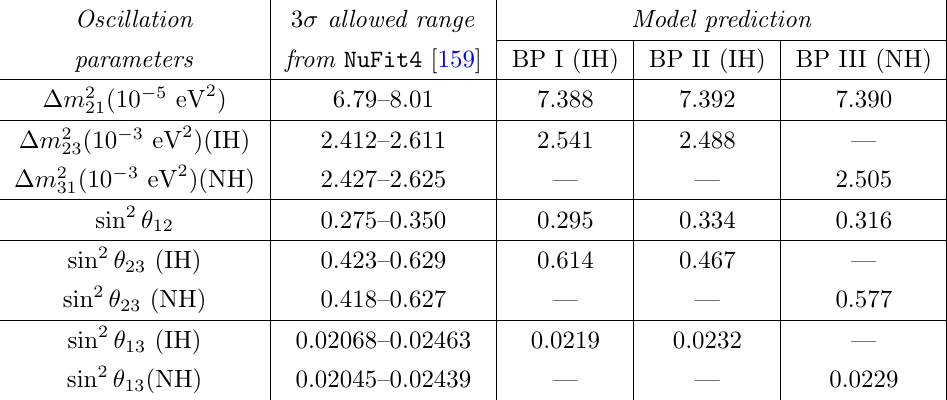
Table 11 . 3 (cid:27) allowed ranges of the neutrino oscillation parameters from a recent global-(cid:12)t [159] (without NSI), along with the model predictions for each